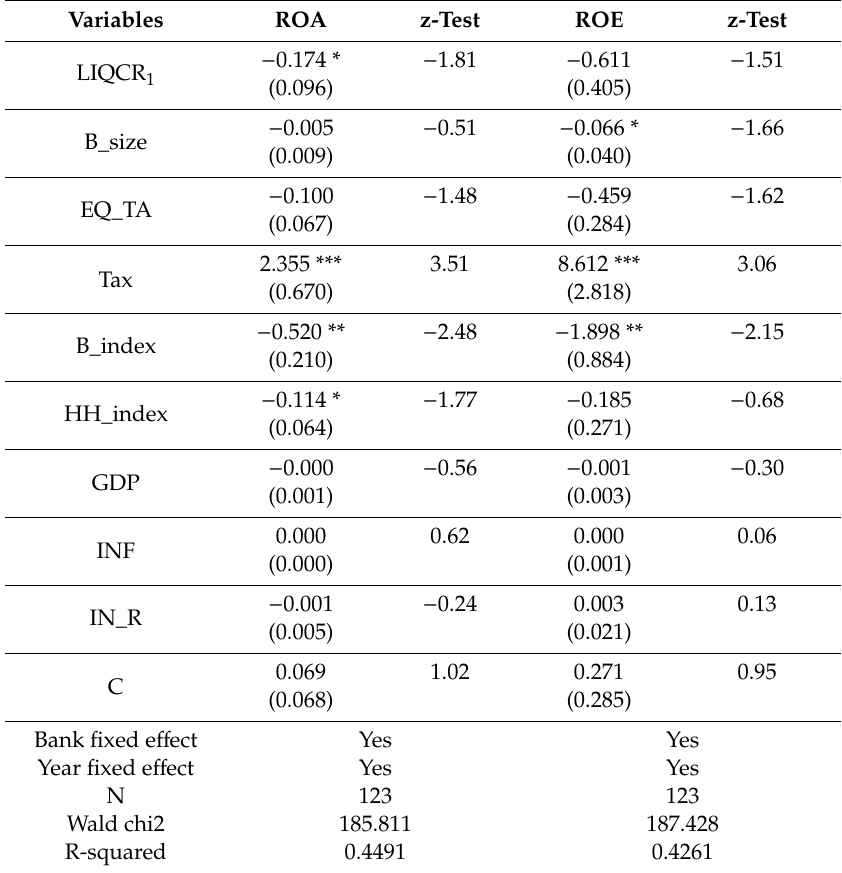
Table 10. Liquidity creation and bank profitability—excluding the Islamic banks. Variables ROA z-Test